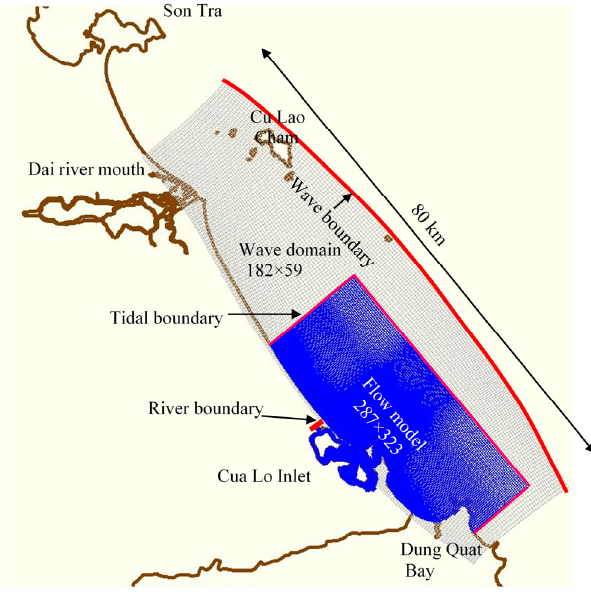
Figure 6. Wave and flow model domains and grid resolutions.